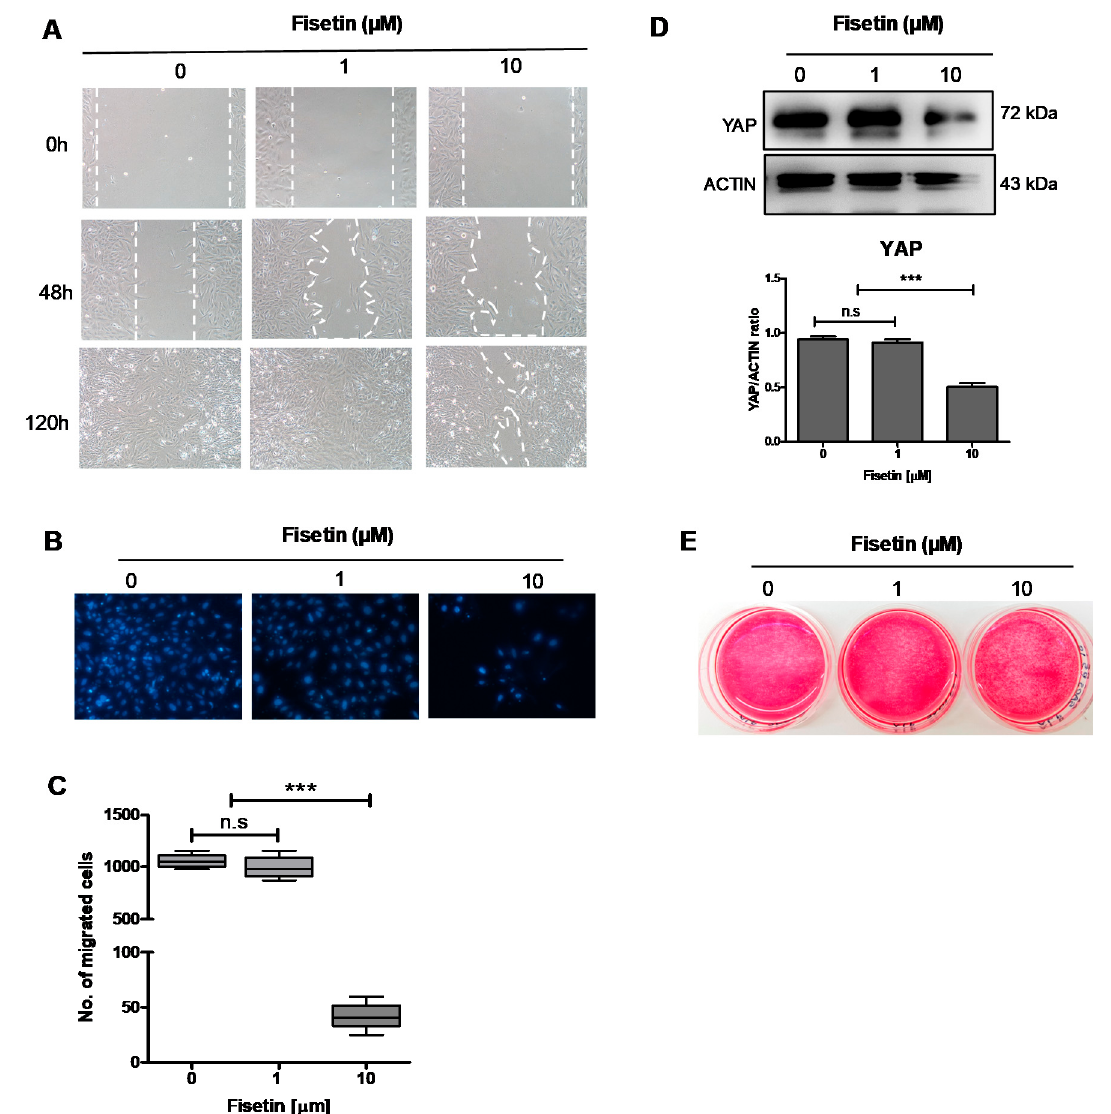
Figure 3. Effect of fisetin on proliferation and migration of SaOs-2 cells. The distance between edges was monitored under inverted microscope to determine gap closure upon fisetin treatment ( A ). Representative pictures of cells at the bottom side of the inserted chamber after 48 h incubation stained with Hoechst-33342 ( B ). The number of migrated cells was counted and reported as mean ± SD; n = 3 ( C ). YAP expression in SaOs-2 cells upon fisetin treatment for 48 h ( D ). Alkaline phosphatase activity staining ( E ). The data presented in subfigure ( C , D ) were analyzed by Mann–Whitney U test. Bars indicate mean values ± standard deviation (SD) and asterisks indicate significant differences, *** p < 0.001; n.s. = no significant difference .